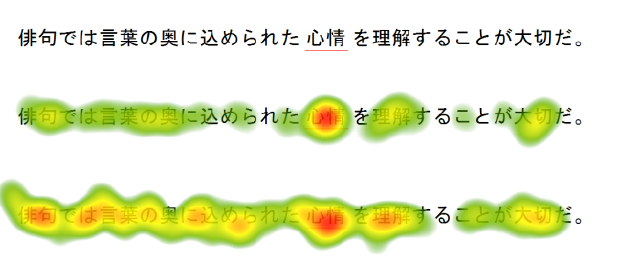
Figure 6 . Example sentences under the two-sentence condition. Top panel: original Japanese sentence (English translation; It is critical to understand the sentiment involved within a word in Haiku, underlined word is sentiment ). Middle panel: The heat- map of 7 high-span participants. Bottom panel: The heatmap of 8 low-span